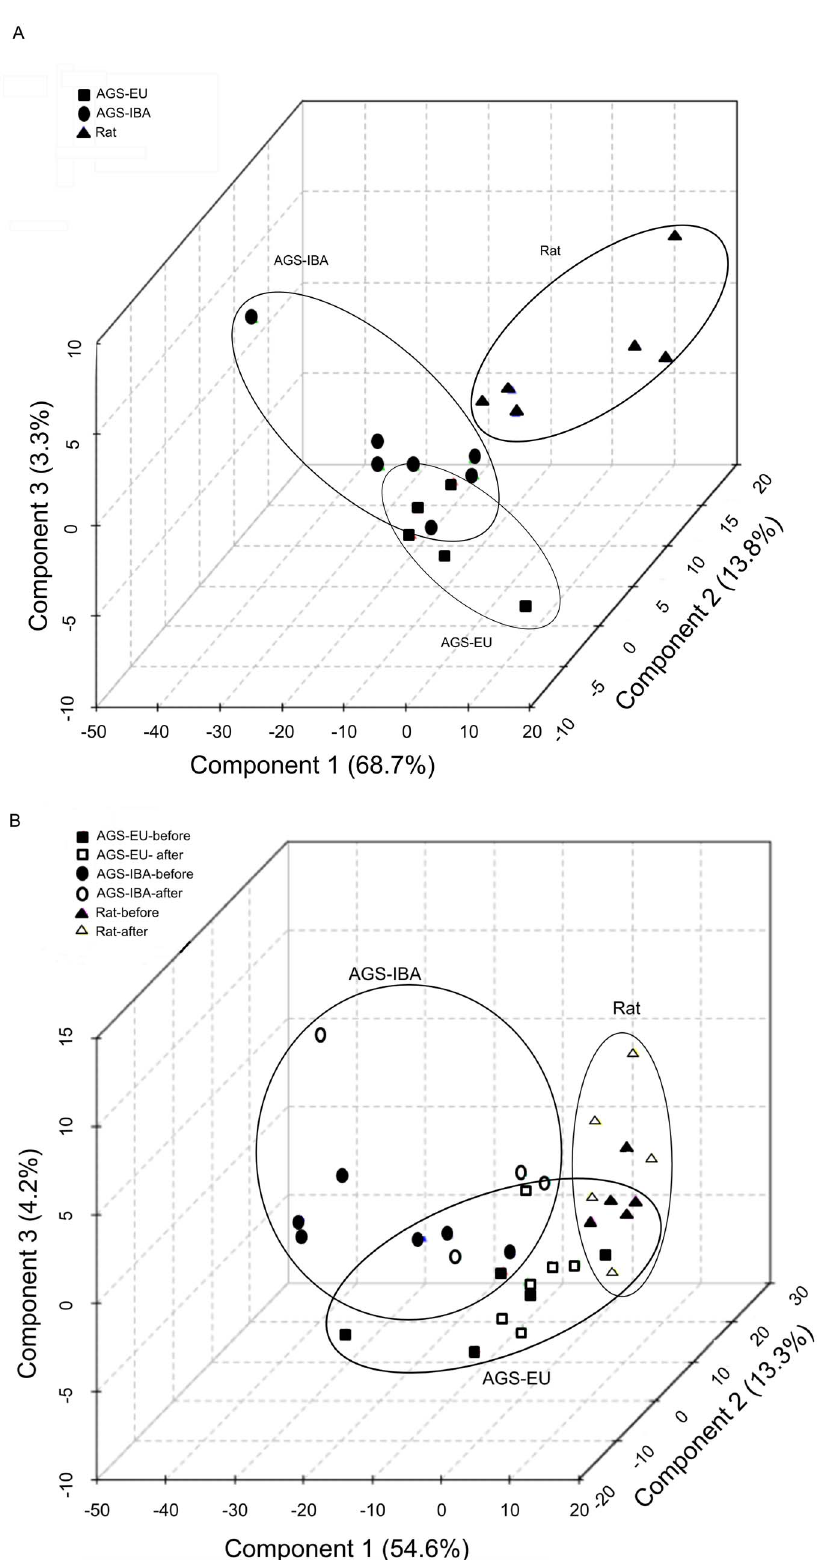
Figure 2. Lipid metabolic profiles. A: Lipid metabolic profiles for naı¨ve rat tended to be distinct from summer euthermic and winter IBA AGS while both season of AGS overlapped via PLS-DA analysis of the 1 H – NMR spectra (R 2 =0.75, Q 2 = 2 0.10, permutation p=0.12). B: Interbout arousal arctic ground squirrels tended to be distinct from I/R prone rats while euthermic arctic ground squirrels overlapped both rats and interbout arousal squirrels in PLS-DA analysis of 1 H – NMR lipid-extracted plasma samples before and after hemorrhagic shock(R 2 =0.70, Q 2 = 2 0.02, permutation p=0.28). For the lipid metabolic profiles, there was not a statistically significant discrimination between the classes. doi:10.1371/journal.pone.0107493.g002 PLOS ONE |